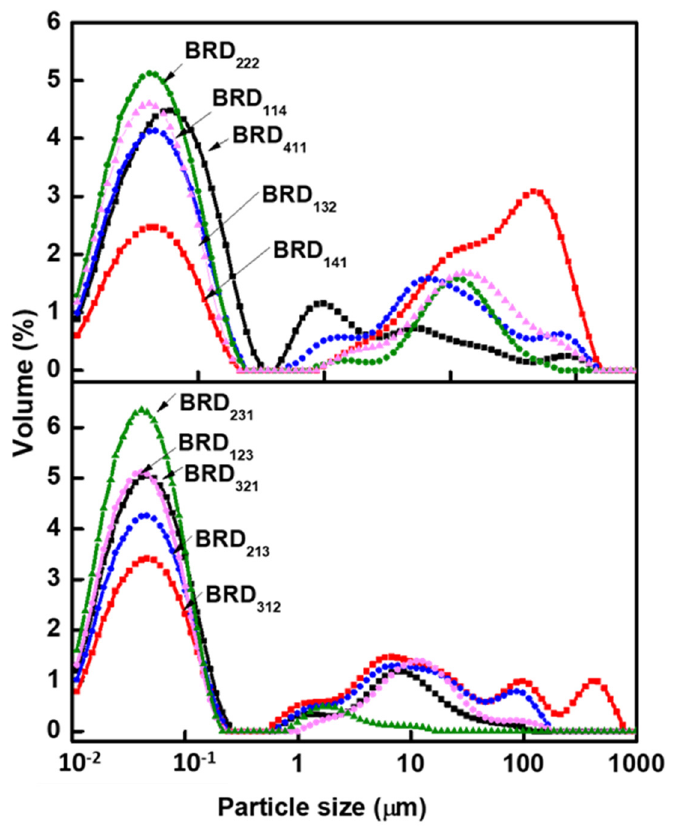
Figure 11. Particle size distribution curves of fluorescent dispersions synthesized with BR.